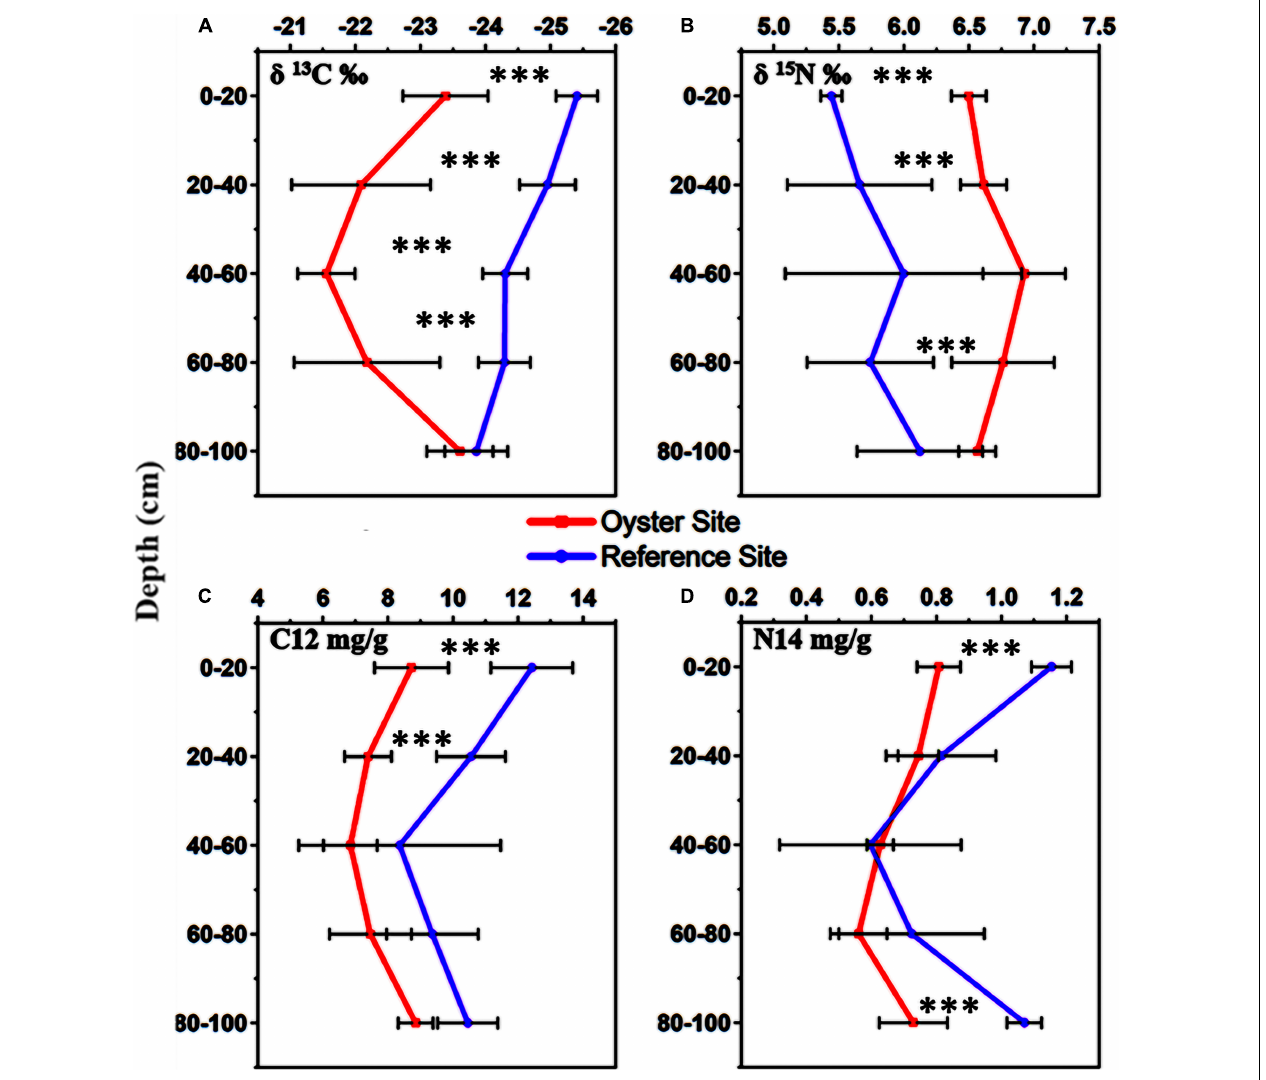
and nitrogen δ 15 (cid:104)